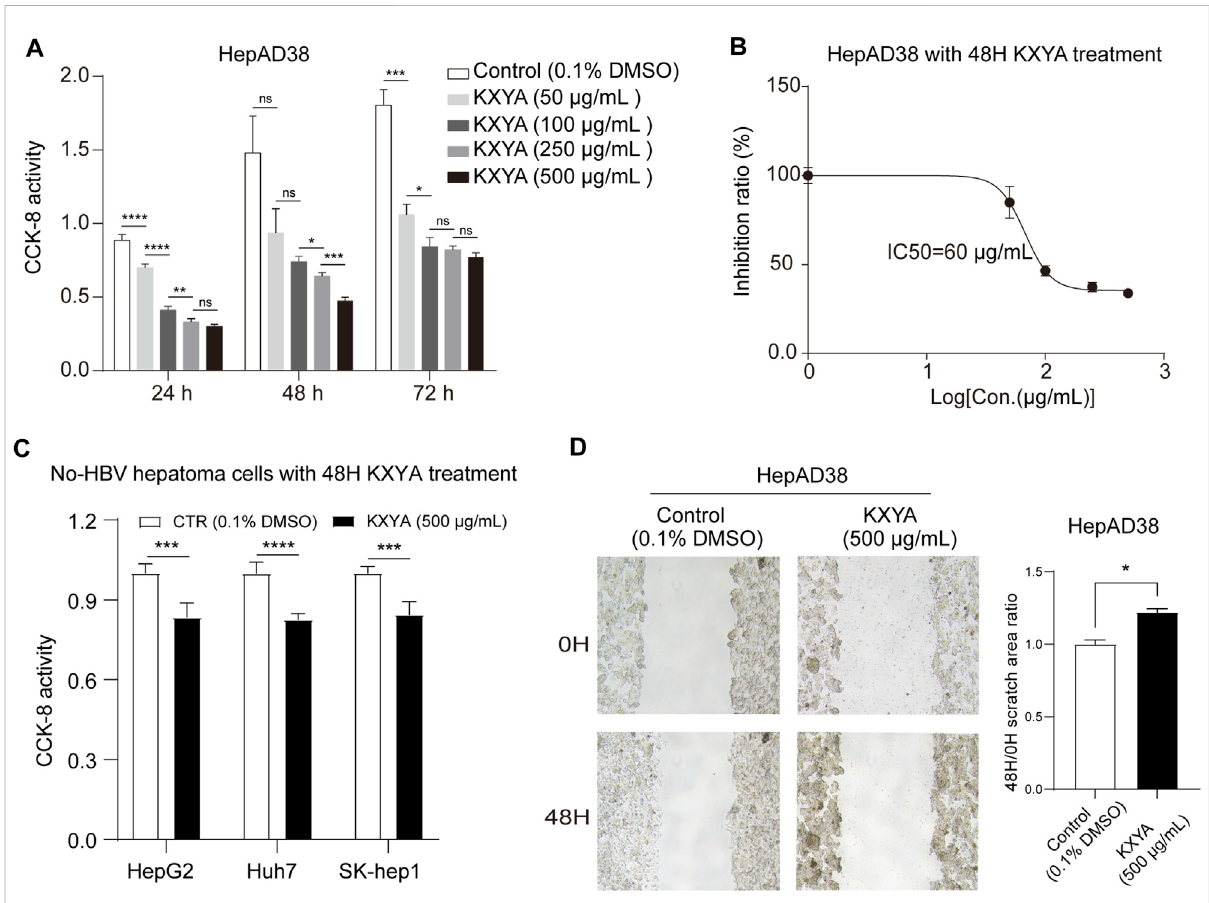
FIGURE 2 KXYAsuppressedproliferationandmigrationofHepAD38cells. (A) HepAD38cellswastreatedwithtime-anddose-increasedKXYA,andthecell viability was detected with CCK-8. (B) HepAD38 cells was treated with dose-increased concentration of KXYA for 48 h and the inhibitory concentration 50 (IC50) was calculated. (C) HepG2, Huh7, and SK-Hep1 cells were treated with KXYA (500 μ g/ml) for 48 h, and the cell viability was detected with CCK-8. (D) The representative images and statistical analysis of migration assay for HepAD38 cells at 0 and 48 h with KXYA treatment. Data are presented as the mean ± SD, p -value was calculated by performing un-pair Student ’ s t -test, *, p < 0.05; **, p < 0.01; ***, p < 0.001, **** p < 0.0001; ns, not signi fi